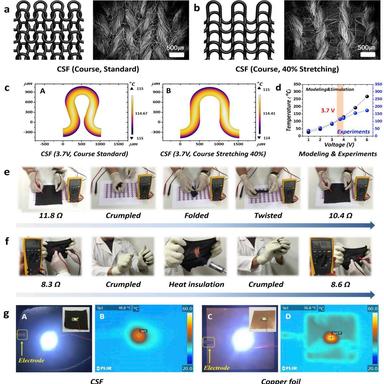
Theoretical thermal diffusion calculations, heat dissipation, heat insulation and stability of the CSF. a, b The scheme and SEM images of the course standard and course stretching (40%), respectively. c A-B, d The Joule heating simulations data in finite element analysis (FEA) of the CSF course (standard (0%) and stretching (40%)) and the temperature comparison between the modeling & simulations of CSF and the experiments. e Photographs of the flexible, crumpled, folded, and twisted CSF as an electrode for